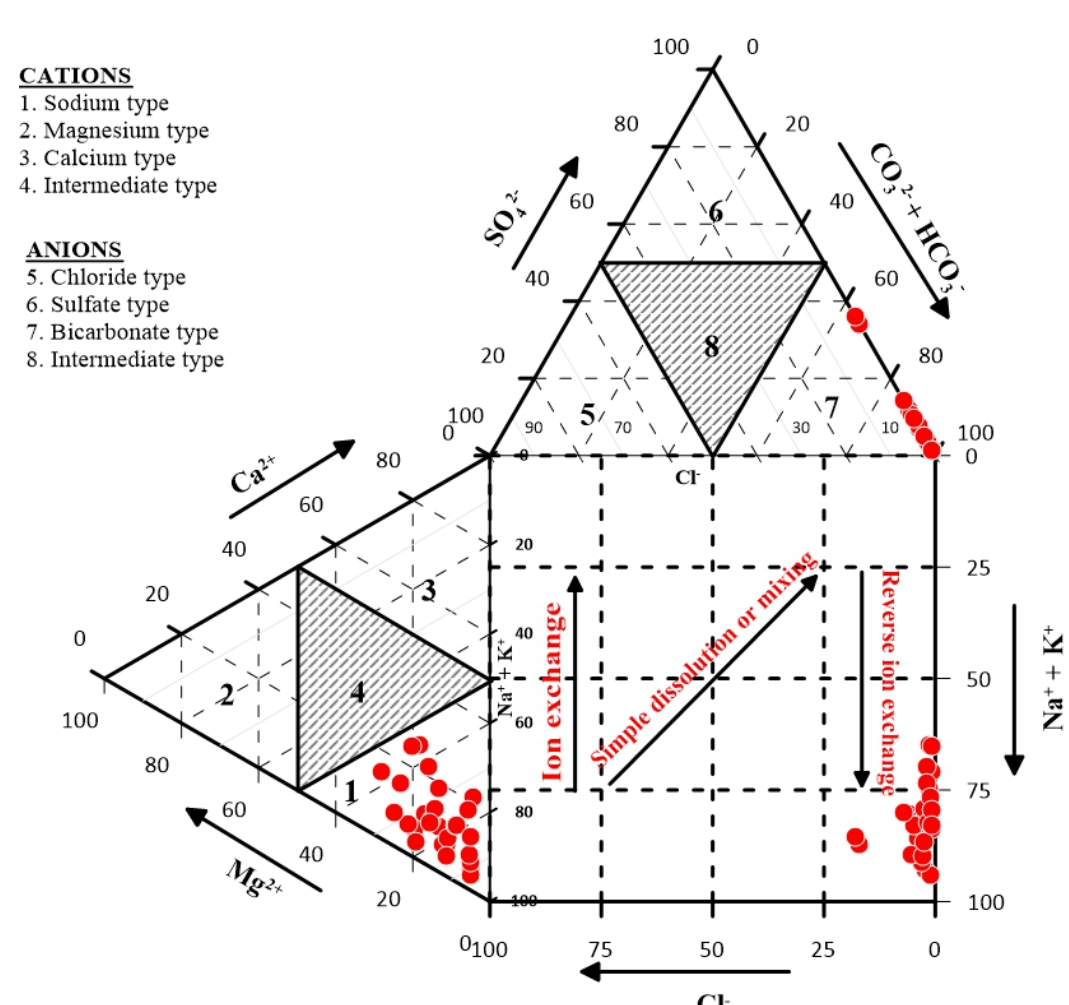
Figure 4. Durov diagram showing hydrochemical facies and processes (Modified from Singh and Kumar [60]).